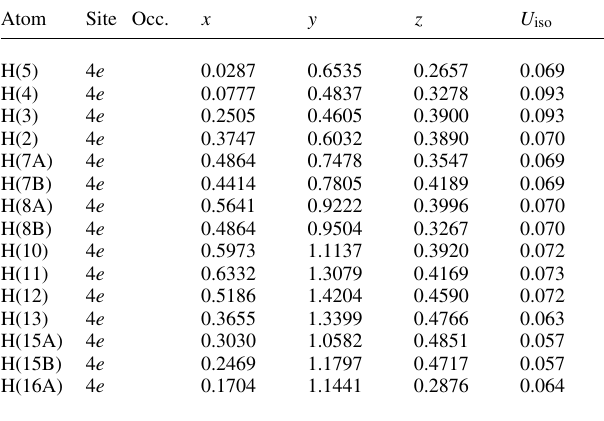
Table 2. Atomic coordinates and displacement parameters (in Å 2 )